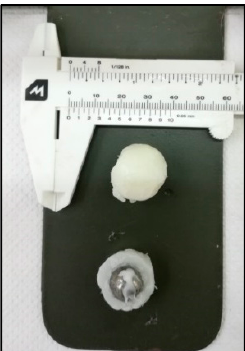
Figure 6. Milling balls after 24 min of milling. A ball completely coated (top) and a ball with the coating partially removed with the help of a sharp cutter.